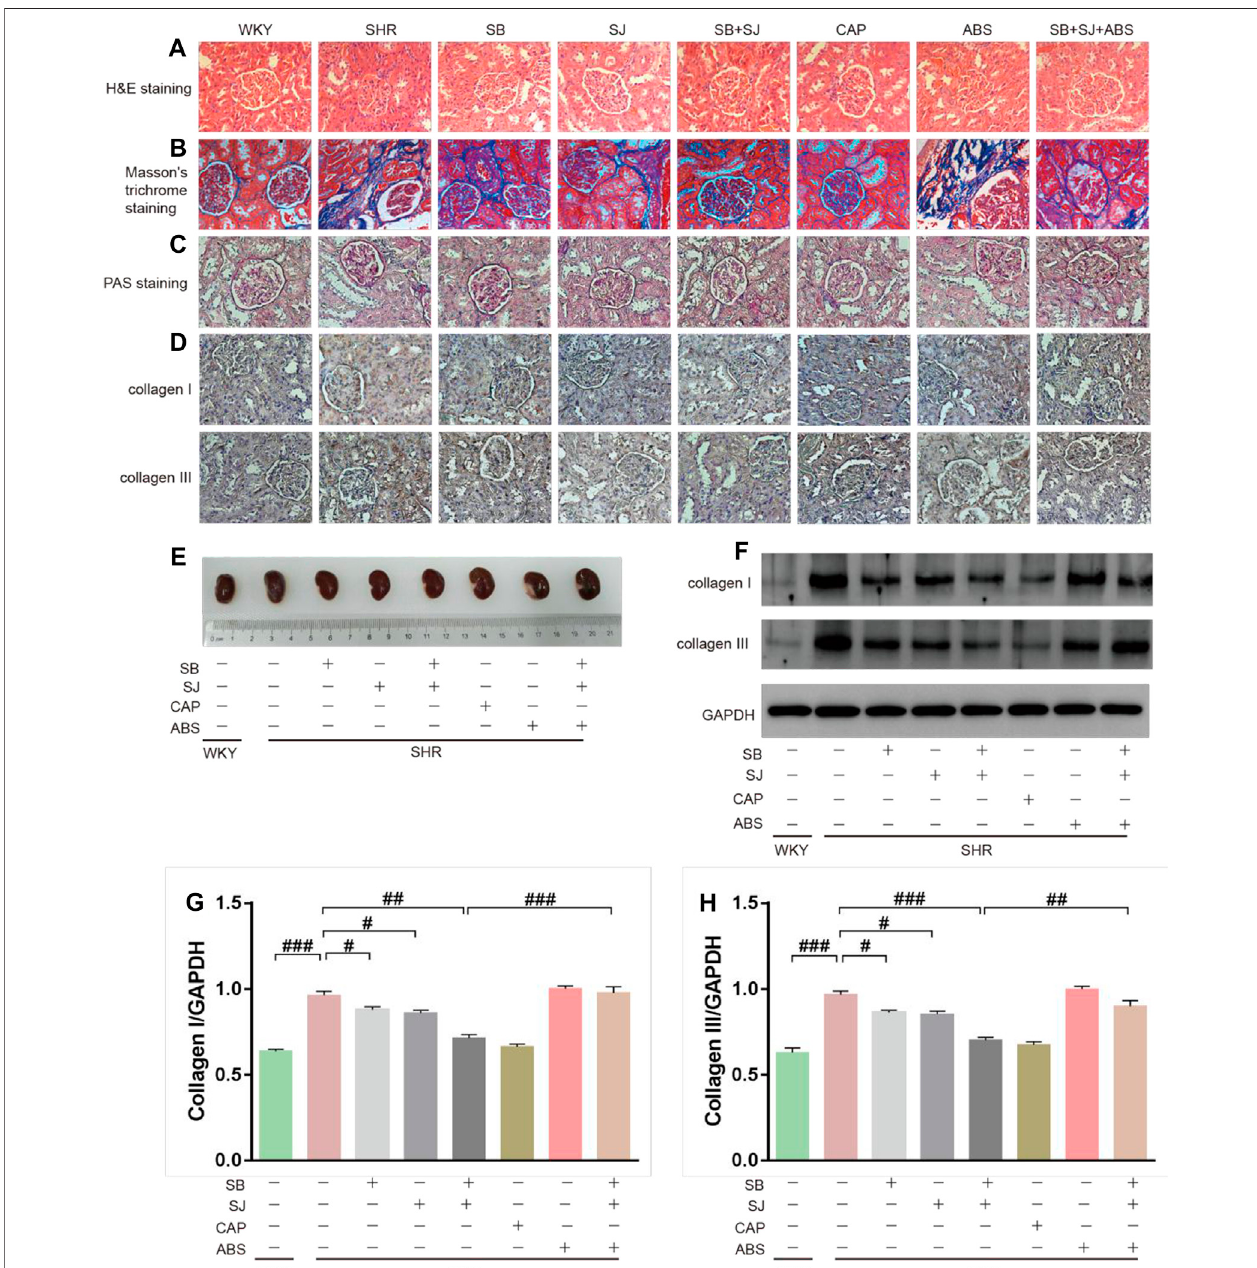
FIGURE 2 | Improvement in renal structure damage by the co-treatment of SB and SJ in SHR. (A – C) Renal tissue histology was measured by HE, Masson ’ s trichrome,andPASstaining.Therepresentativeimagesweretakenfromtherenaltissueslides(Magni fi cation,40 × ). (D) IHCstainingofcollagenIorcollagenIIIintherenal tissue;thedarkbrownstainingindicatesapositivestain. (E) Representativephotographsofleftkidneytissues. (F – H) WesternblottingresultsofcollagenIandcollagenIII and their respective quanti fi cation in kidneys. Data are presented as mean ± SD. ### p < 0.001. ## p < 0.01. # p < 0.05.